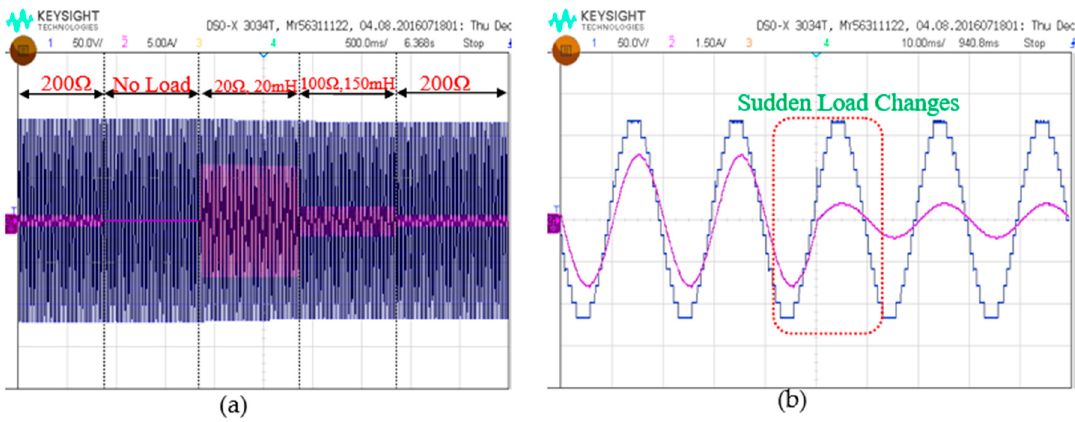
Figure 13. Experimental results of thirteen-level converter; ( a ) different loading conditions and ( b ) zoomed view of load changes.